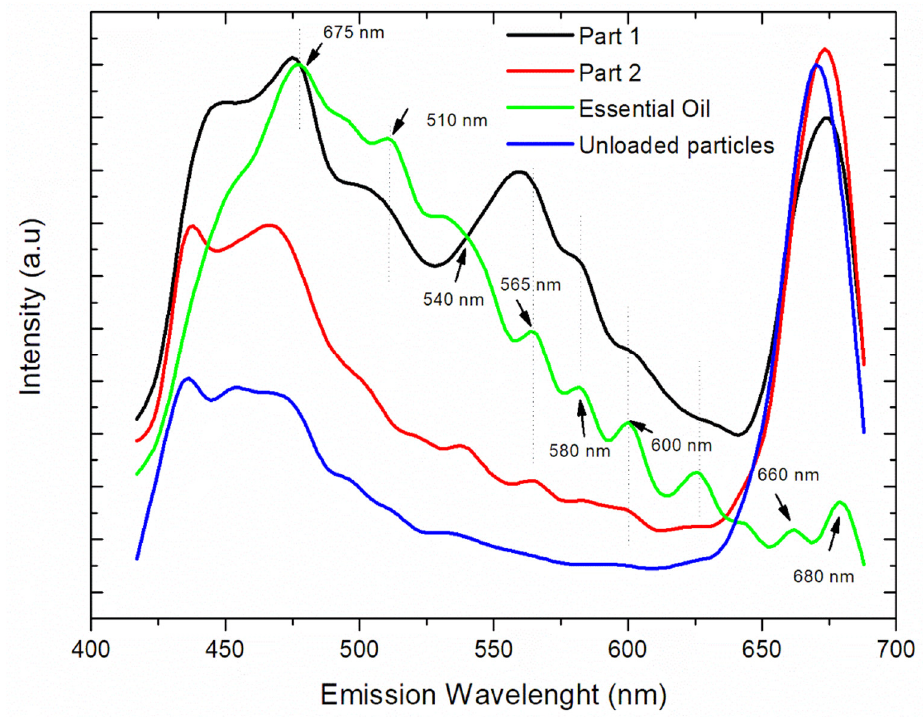
Figure 7. Fluorescence measurements of the loaded particle (part 1 and 2), essential oil in natura and unloaded particle.